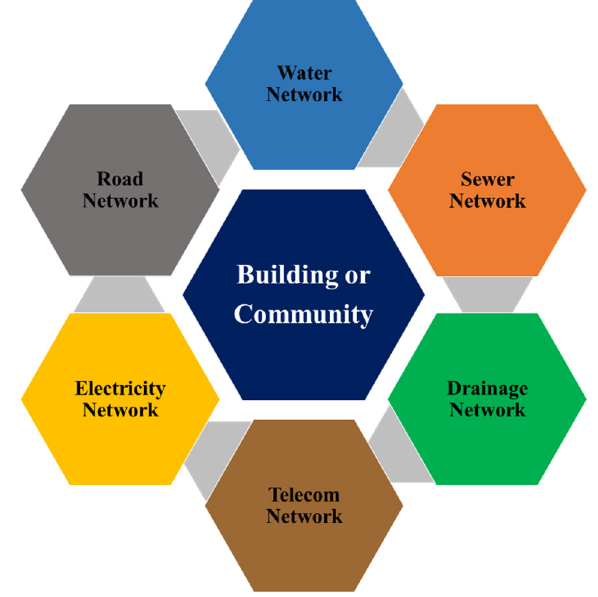
Figure 1. Critical Infrastructure Networks in a Society.